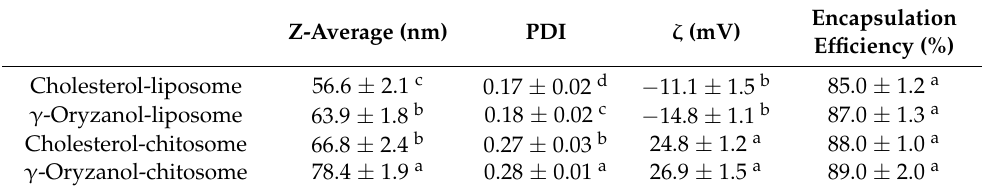
Table 1. Characteristics of hydrolysate-loaded γ -oryzanol-liposome and chitosome.